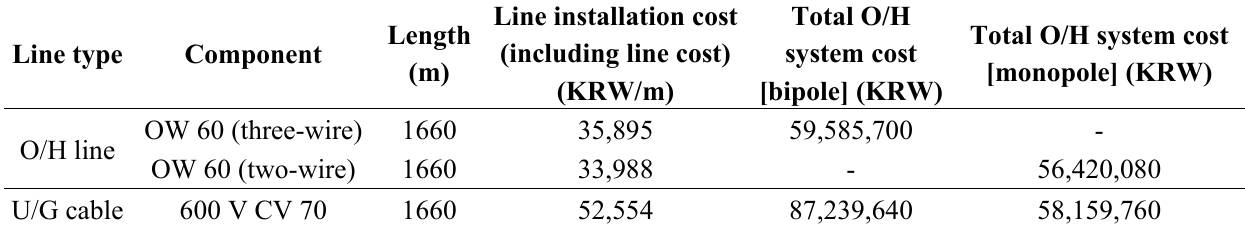
Table 4. Line material and installation costs of